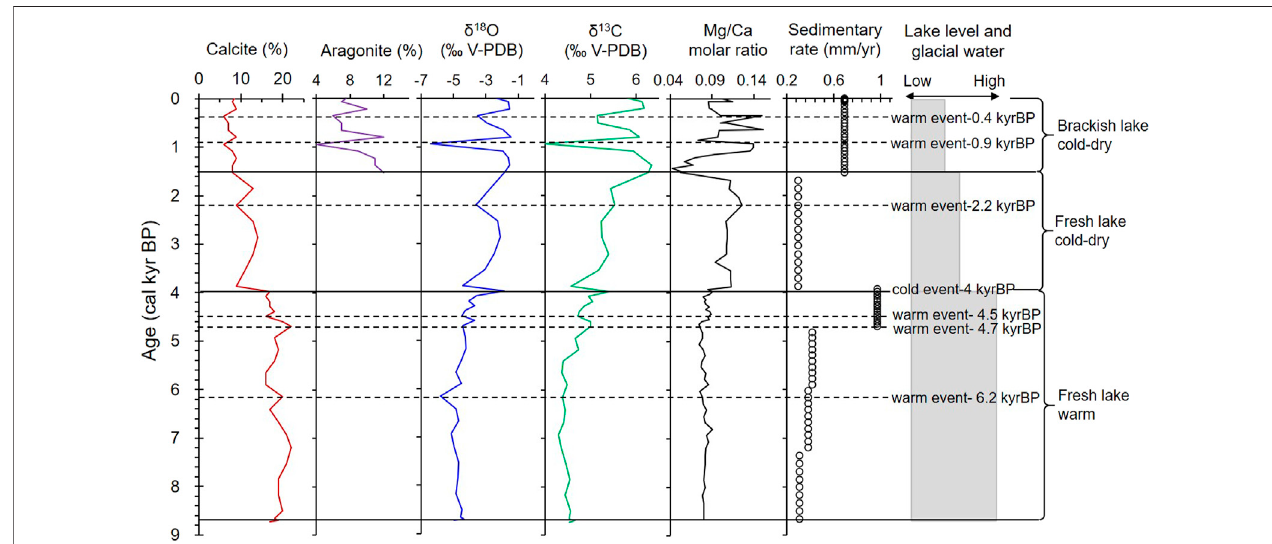
FIGURE 3 | Overview of the ages and multiple proxies for core GZLC15-1, showing the changes in the sedimentary environment and climate since 8.7 kyr BP.